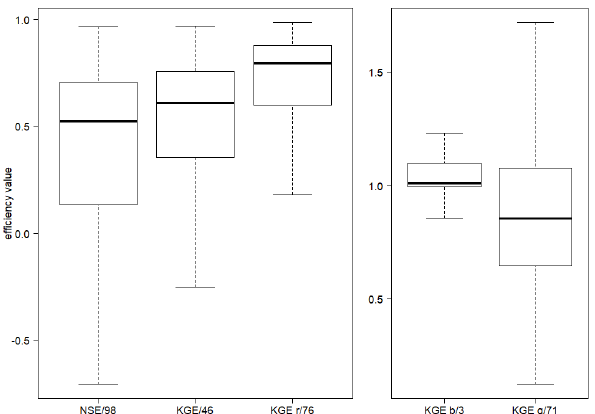
Figure 6. Efficiency metrics for monthly streamflow of WaterGAP 2.2d at the 1319 GRDC stations with NSE, KGE and its compo- nents. Outliers (outside 1.5 × inter-quartile range) are excluded but the number of stations that are defined as outliers are indicated after the metric.